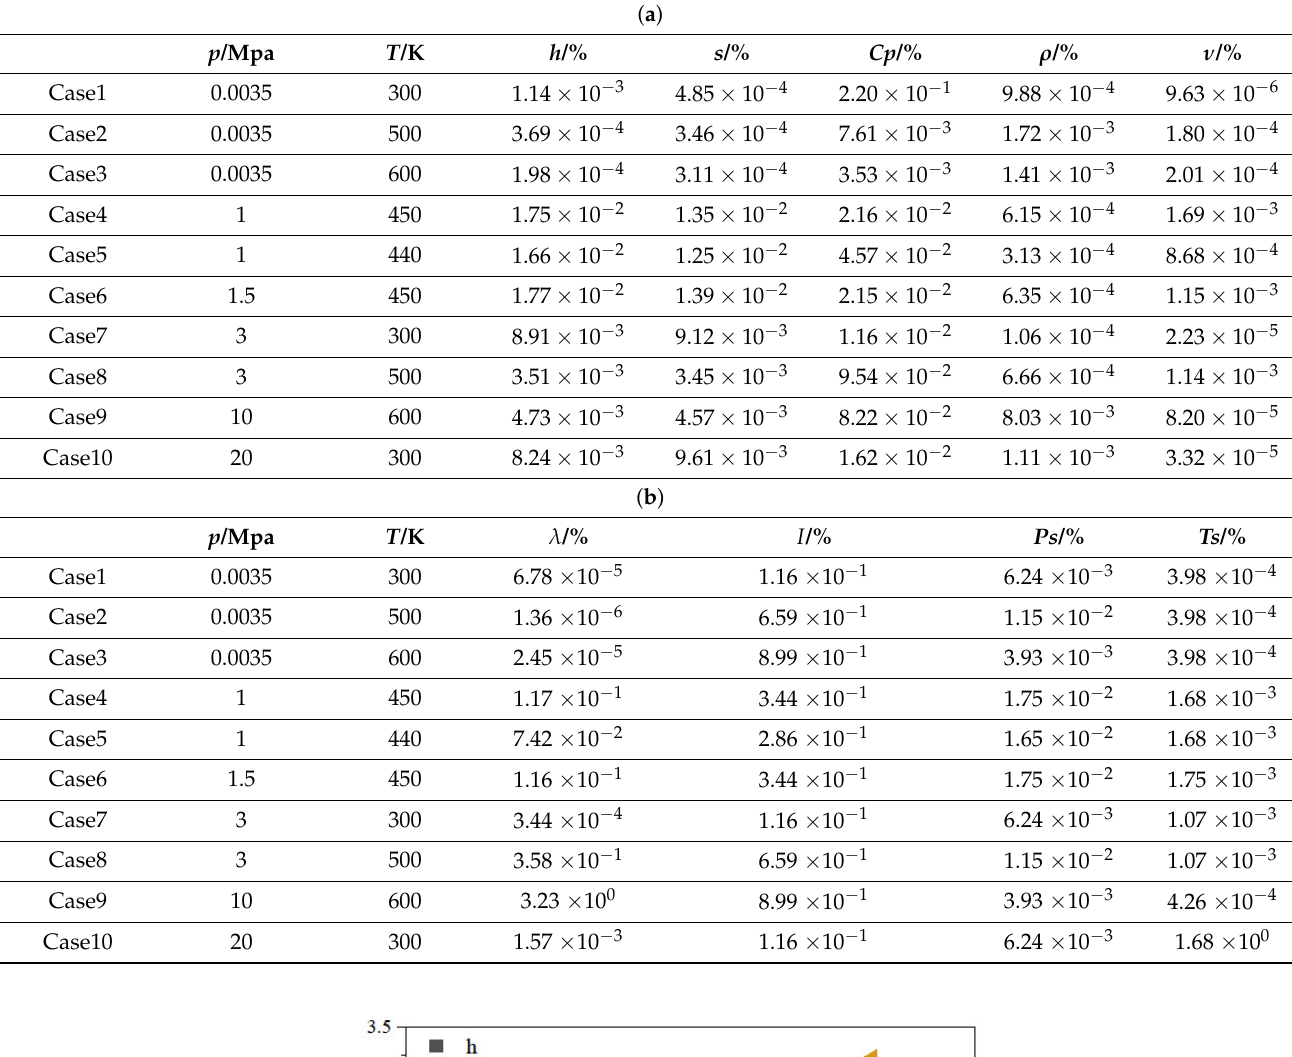
Table 5. (a) The relative error in f ( p,T ) compared with IAPWS-95. (b) The relative error in f ( p , T ) compared with IAPWS-95.